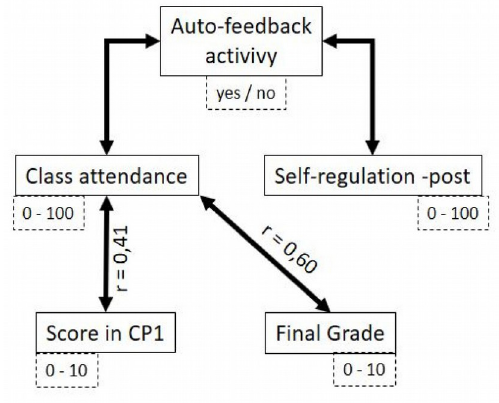
Figure 6. Significant relationships between post- treatment self-regulation and auto-feedback. Arrows indicate a significant effect in the analysis of variance and/or correlation and dotted lines the range of the variable